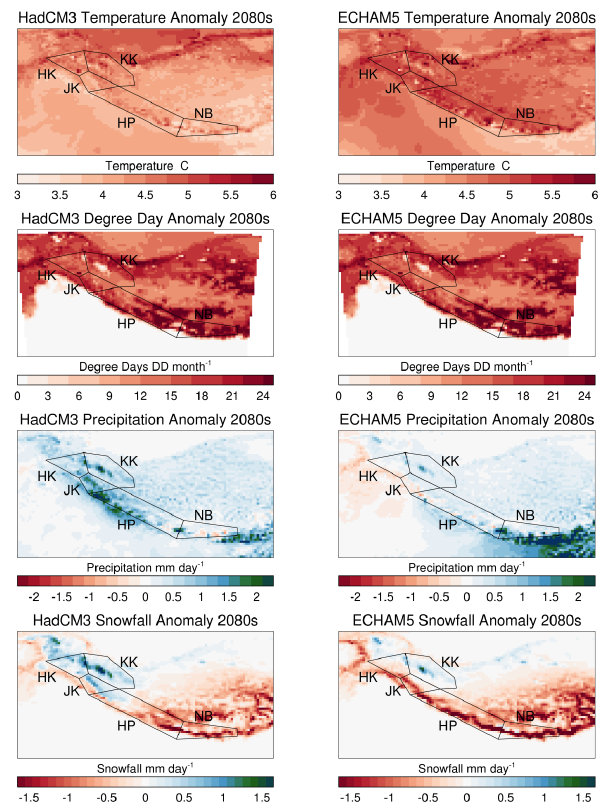
Figure 7: Projected changes in regional climate by the 2080s relative to 1992-2008 from the 839 Figure 7. Projected changes in regional climate by the 2080s rel- downscaled HadCM3 and ECHAM5 A1B simulations. Plots show change in annual average 840 ative to 1992–2008 from the downscaled HadCM3 and ECHAM5 temperature, degree days, precipitation and snowfall. 841 A1B simulations. Plots show change in annual average temperature, degree days, precipitation and